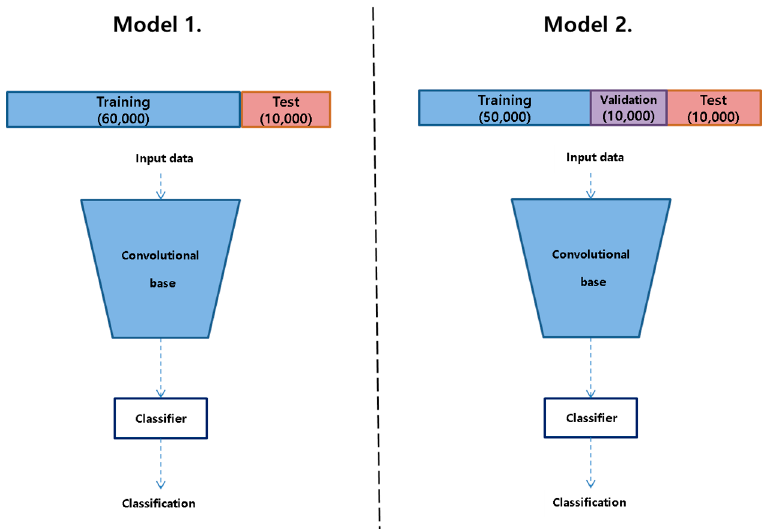
Figure 7. Schematics for datasets used with Model 1 and Model 2. Table 2. Preference classification results with the Fashion-MNIST dataset.